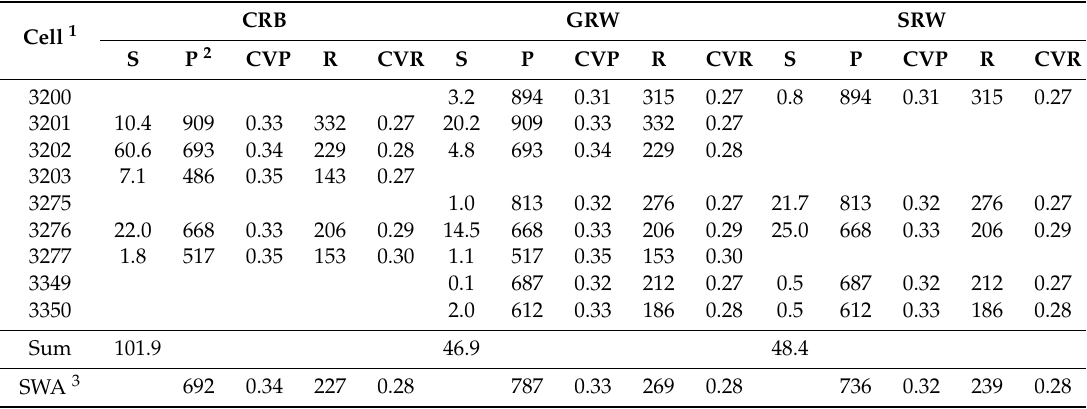
Table 2. For the 10 km × 10 km cells covering the CRB and upstream GRW and SGW contributing areas, the CMB datasets gathered from Alcal á and Custodio (2014, 2015) [34,42]. Cell 1